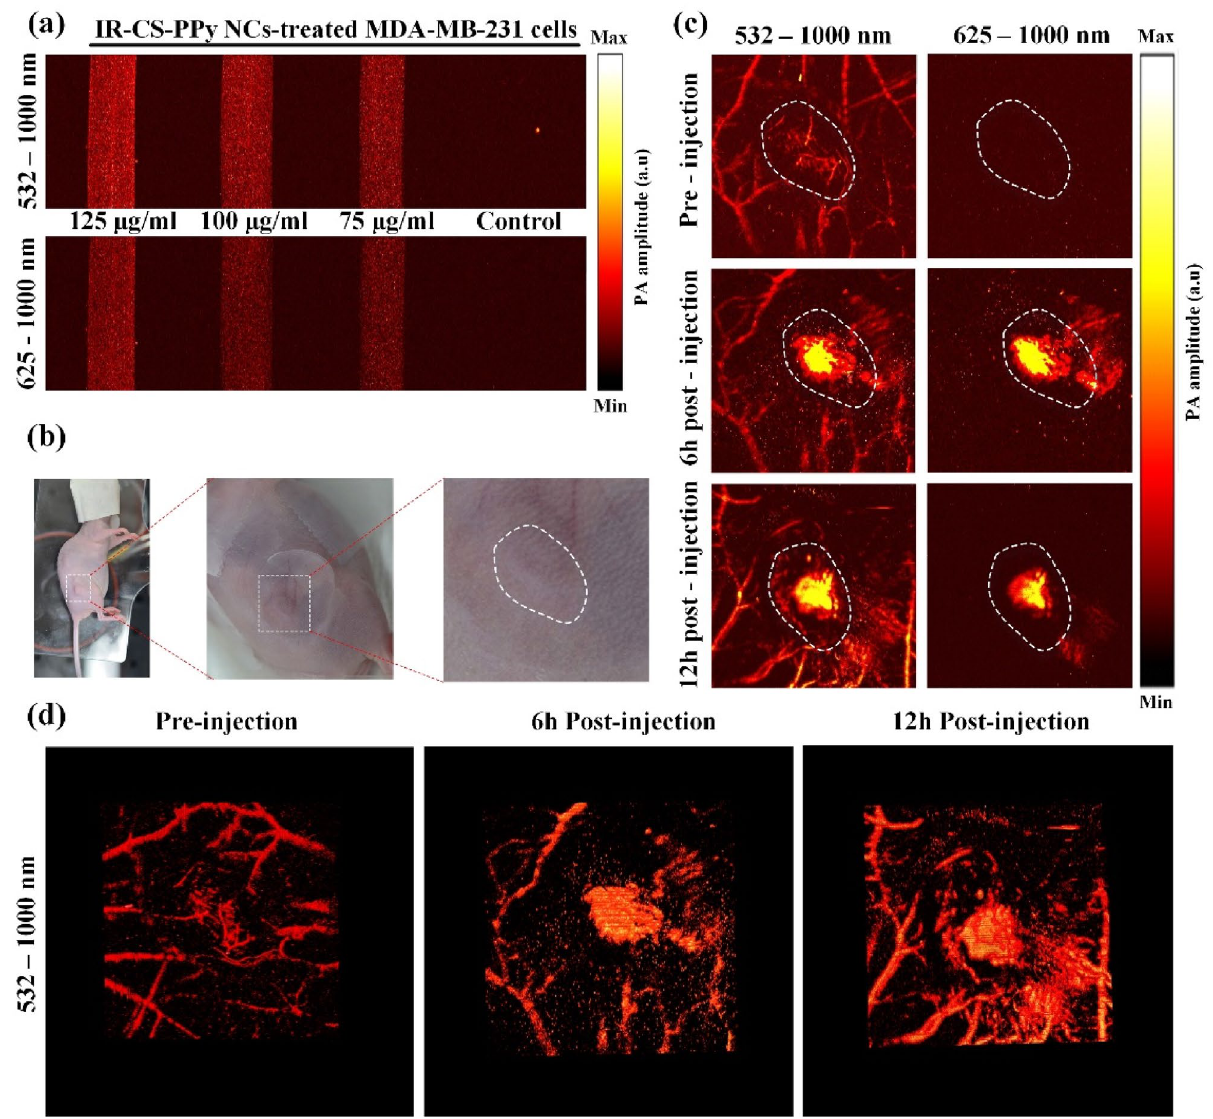
Figure 7. ( a ) In vitro PAI of MDA-MB-231 cells incubated with various concentrations of IR-CS–PPy NCs using PAI system with 532–1000 nm wavelength and 625–1000 nm wavelength. ( b ) Representative digital photographs of MDA-MB-231 tumor-bearing nude mice for in vivo PAI. The white dash lines indicate the tumor area. ( c ) In vivo PAI of tumor tissues in MDA-MB-231 tumor-bearing nude mice at 0, 6, and 12 h after injection of IR-CS–PPy NCs (100 μL) using PAI system with 532–1000 nm wavelength, and 625–1000 nm wavelength. ( d ) Representative 3D PA images of tumor tissues MDA-MB-231 tumor-bearing nude mice at 0, 6, and 12 h after injection of IR-CS–PPy NCs using PAI system with 532–1000 nm